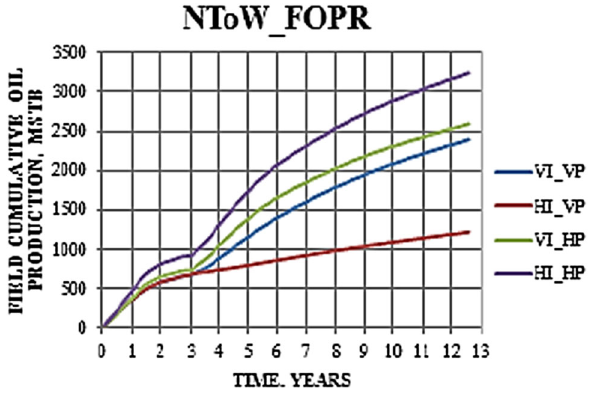
Fig. 24 Plot of the field cumulative oil production versus time for different NToW